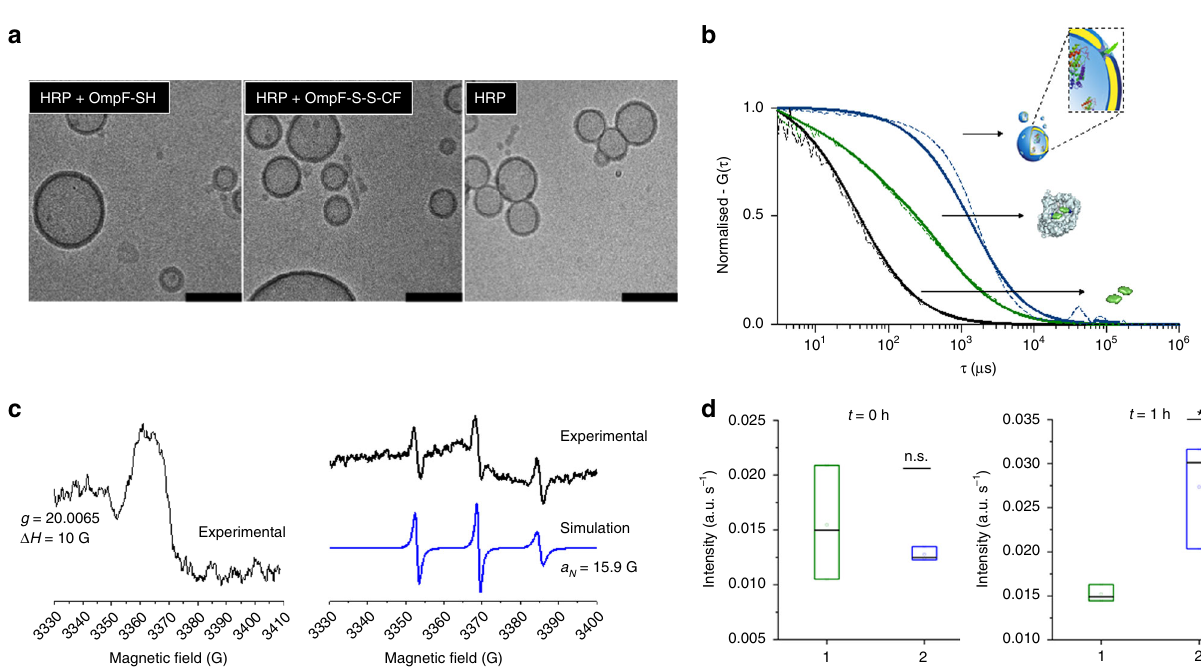
Fig. 3 Characterisation of stimuli-responsive catalytic nanocompartments. a Cryo-TEM micrographs of: (left) polymersomes loaded with HRP and equipped with OmpF-SH, (middle) polymersomes loaded with HRP and equipped with OmpF-S-S-CF, and (right) polymersomes loaded with HRP without OmpF. Scale bar = 100 nm. b Normalised FCS autocorrelation curves of SAMSA-CF in PBS (black) and OmpF-S-S-CF in the membrane of polymersomes (blue). Dotted line = experimental autocorrelation curves, solid line = fi tted curve. Curves normalised to 1 to facilitate comparison. c Left panel: EPR spectrum of bis-(2,2,5,5-tetramethyl-3-imidazoline-1-oxyl-4-yl) disulphide-labelled OmpF reconstituted in PMOXA-PDMS-PMOXA polymersomes (black line). c Right panel: bis-(2,2,5,5-tetramethyl-3-imidazoline-1-oxyl-4-yl) disulphide-labelled OmpF reconstituted in PMOXA-PDMS-PMOXA polymersomes and incubated with 10 mM DTT experimental (black line) and simulated (blue line). d Amplex Ultra Red conversion of HRP-loaded polymersomes: immediately after addition of 30 mM GSH (left), and 1 h after addition of 30 mM GSH (right). OmpF-S-S-CF equipped HRP-loaded polymersomes (green) and OmpF-SH equipped HRP-loaded polymersomes (blue). Error bars present standard deviations in activity between three separately prepared